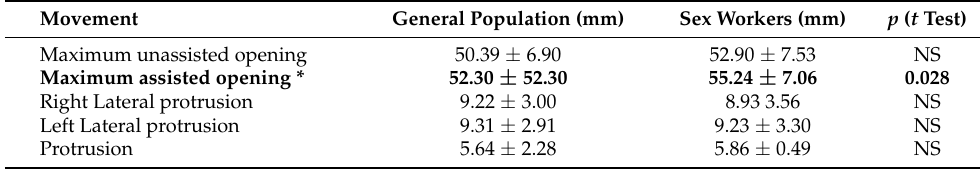
Table 2. Opening, lateral and protrusive movements.